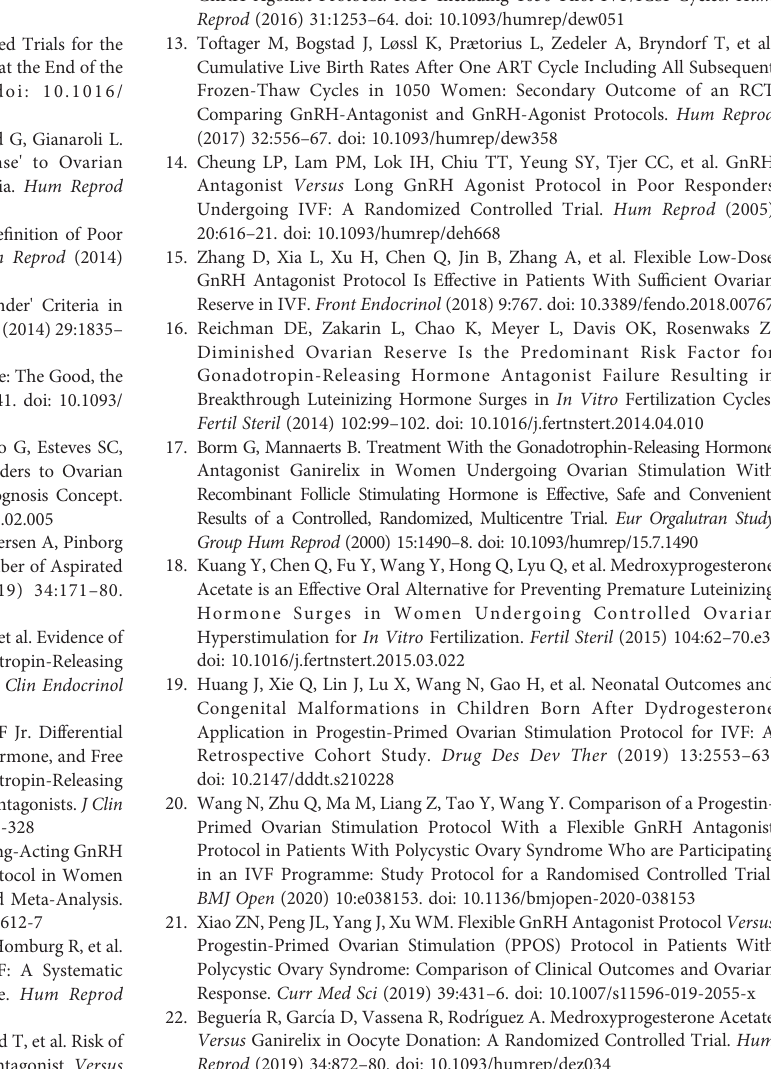
Supplementary Table 1 | Baseline and cycle characteristics of the Poseidon 1 and 2 groups from previous